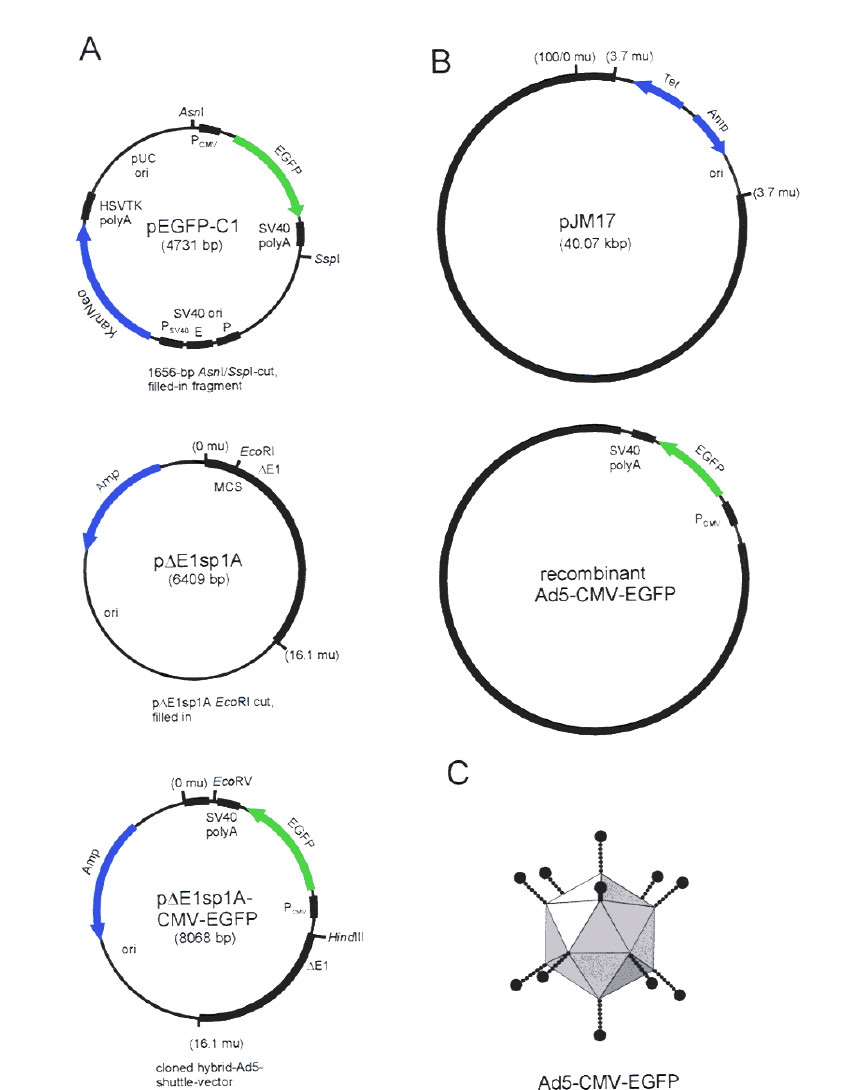
Figure 3 Construction of a replication-defective recombinant adenovirus expressing enhanced green fluorescent pro- tein under transcriptional control of the human cytomegalovirus immediate-early gene 1 promoter/enhancer. (A) In the mammalian reporter vector pEGFP-C1 the enhanced green fluorescent protein (EGFP) is expressed under control of the human cytomegalovirus immediate-early gene 1 promoter (P ). Abbreviations are: Kan/Neo, kanamycin/neomycin CMV resistance genes; Amp, ampicillin resistance gene; pUC ori, E. coli origin of replication; SV40 ori, simian virus 40 origin of repli- cation; SV40 polyA, simian virus 40 polyadenylation signal; HSVTK polyA, herpes simplex thymidine kinase polyadenylation sig- nal. The adenoviral shuttle vector p ∆ E1sp1A contains Ad5 sequences from bp 22 (0 mu) to bp 5790 (16.1 mu) with a deletion of E1 sequences ( ∆ E1) from bp 342 to bp 3523 (1.0 - 9.8 mu) and a selectable ampicillin resistance gene (Amp). A multiple clon- ing site (MCS) containing unique restriction sites for Cla I, Bam HI, Xho I, Xba I, Eco RV, Eco RI, Hind III, Sal I, and Bgl II is embedded in the Ad5-sequences. For construction shuttle vector p ∆ E1sp1A-CMV-EGFP the 1656-bp Asn I/ Ssp I fragment from plasmid pEGFP-C1 was filled in by Klenow DNA polymerase and cloned into the Eco RI digested and filled in p ∆ E1sp1A vector. (B) For integration of the reporter cassette from pE1 ∆ sp1A-CMV-EGFP into the Ad5 backbone plasmid vector pJM17 both plasmids were cotransfected into human embryo kidney cell line 293 leading to homologous recombination between common Ad5 regions. Generation of recombinant viral particles were visualized by an increase of EGFP-positive cells and by viral focus for- mation in fluorescence microscopy. (C) Released replication-defective viral particles are infectious and are capable to deliver the CMV-EGFP cassette to target cells. The nucleotide sequence of the cloned vector p ∆ E1sp1A-CMV-EGFP is deposited in GenBank (Accession number